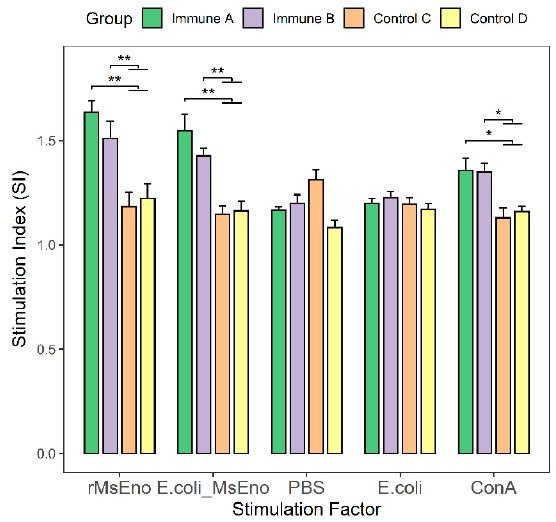
Figure 5. The proliferation of T lymphocytes in mice. The mice were divided into four groups ( n = 5 per group) and stimulated with rMseno, E. coli -Mseno, PBS, E. coli , and ConA, respectively. Between groups, statistical comparisons were made using different stimulating factors. * p < 0.05 presents a significant difference, and ** p < 0.01 shows a highly significant